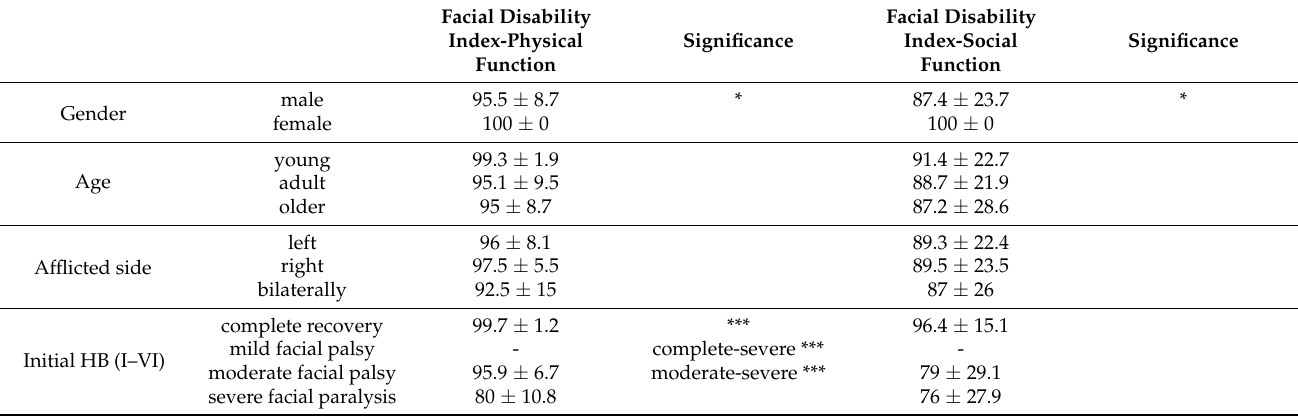
Table 2. Mean values and standard deviation of neurotological parameters for FDI-physical